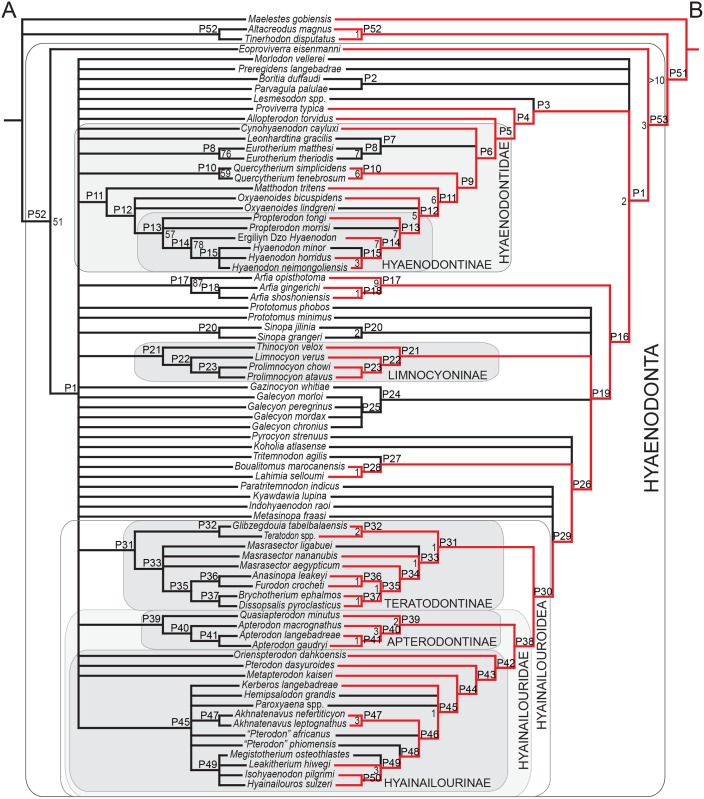
Parsimony consensus trees.Consensus trees of 1262 most parsimonious trees (MPTs), each with 1066 steps, a consistency index score (CI) of 0.181, and a retention index score (RI) of 0.617. P# next to each node is used in the discussion of the consensus trees. A, strict consensus tree with Bootstrap support great than 50% indicated next to the relevant node; B, Adams consensus tree with an agreement subtree for all MPTs indicated in red. The agreement subtree shows relationships recovered in all MPTs. Bremer support values are shown next to relevant nodes. Major clades discussed in this study are enclosed with the clade name by rounded boxes.